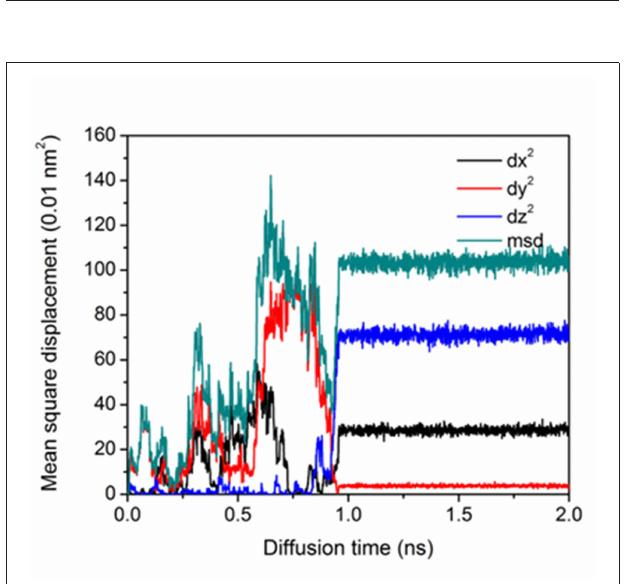
FIGURE 3 | MSD as a function of diffusion time of P atom in model P 19{331} at 600K.